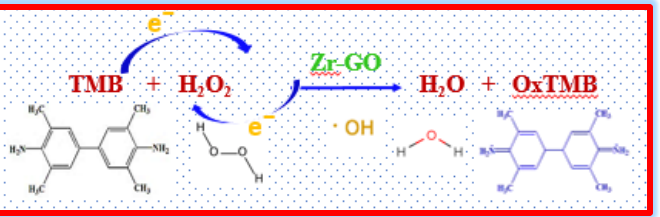
Figure 11. The reaction mechanism of Zr-GO peroxidase mimic-catalyzed oxidation TMB in the presence of H 2 O 2.